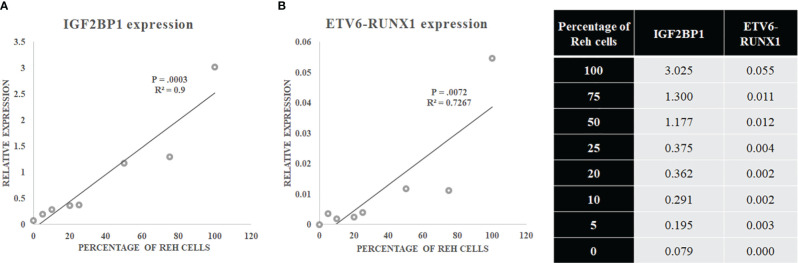

(A) IGF2BP1 and (B) ETV6-RUNX1 expression in a mixture of Reh (corresponding to blasts) and PBMCs.